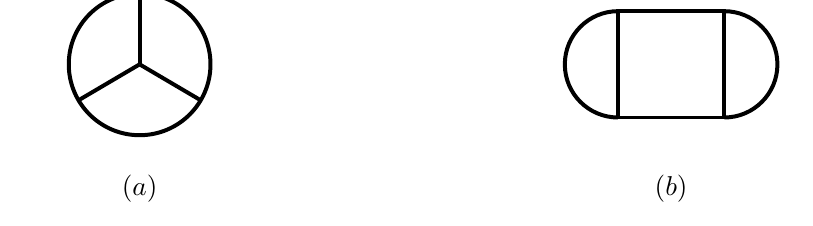
Figure 4 . ( a ) Skeleton of the tetrahedron diagram; ( b ) Skeleton of the three-loop ladder diagram; in both cases, the four external gravitons can attach to any of the